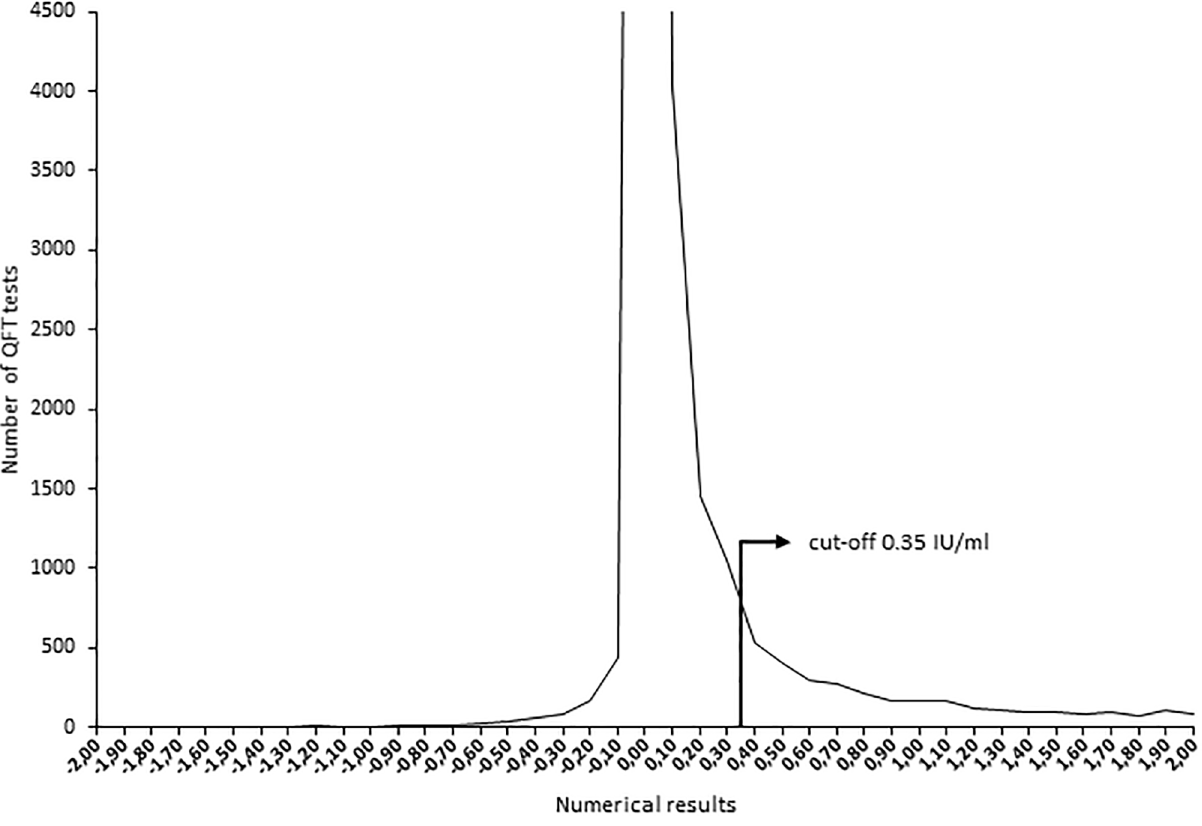
Fig 1. Distribution of numerical QFT results from -2 to +2 IU/ml (1 n = 33225)where the range -0.05 to 0.04 IU/ml reachesoutside the graph as the large number of observations in this range distorts the scale (n = 22645).